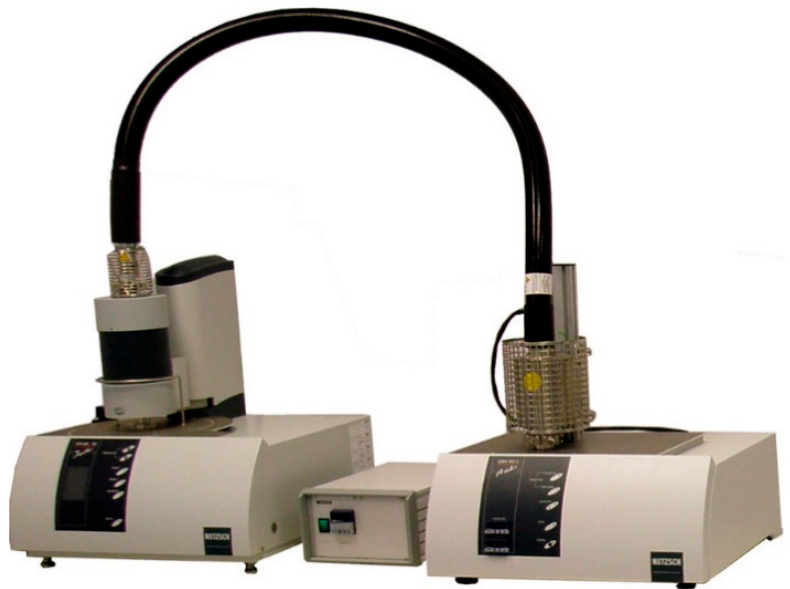
Figure 5. Analyzer NETZSCH STA 449 Jupiter F1 coupled with QMS Aëolos analyzer.